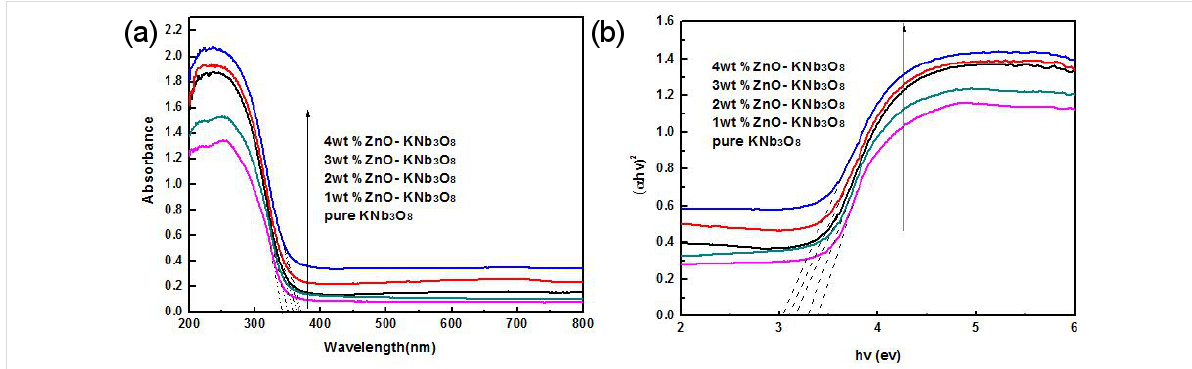
Figure 7: (a) UV–vis diffuse reflectance spectra of the ZnO quantum dot/KNb 3 O 8 nanosheet composite photocatalysts; (b) ( α hv ) 1/2 versus the photon energy of the ZnO quantum dot/KNb 3 O 8 nanosheet composite photocatalysts.